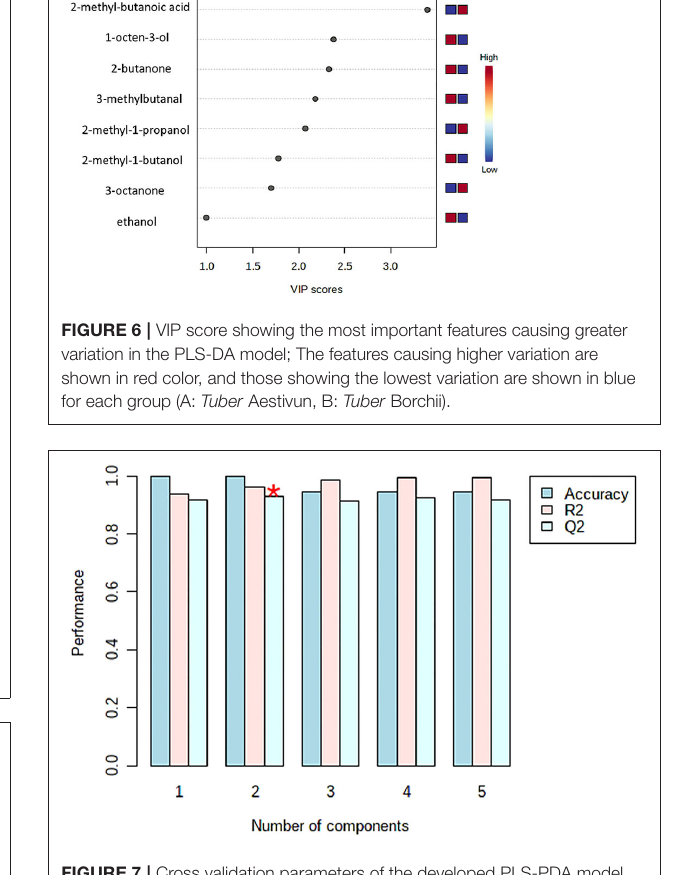
was developed in the MetaboAnalyst platform. The PLS-DA model successively grouped the samples according to the species